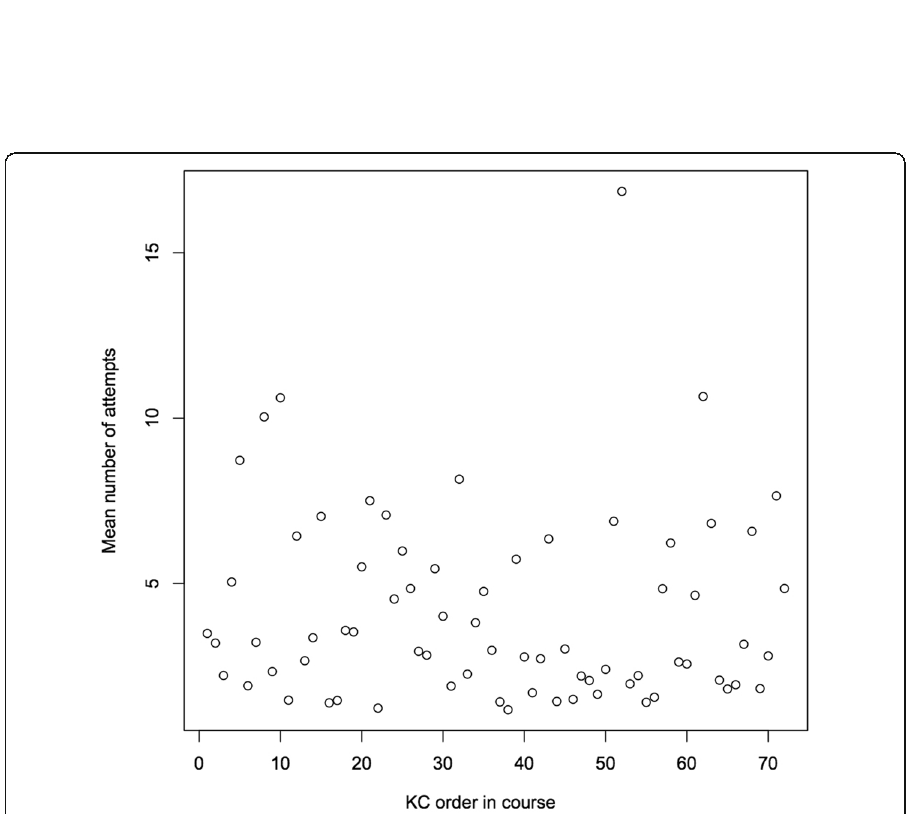
Fig. 4 Distribution of mean number of attempts over the